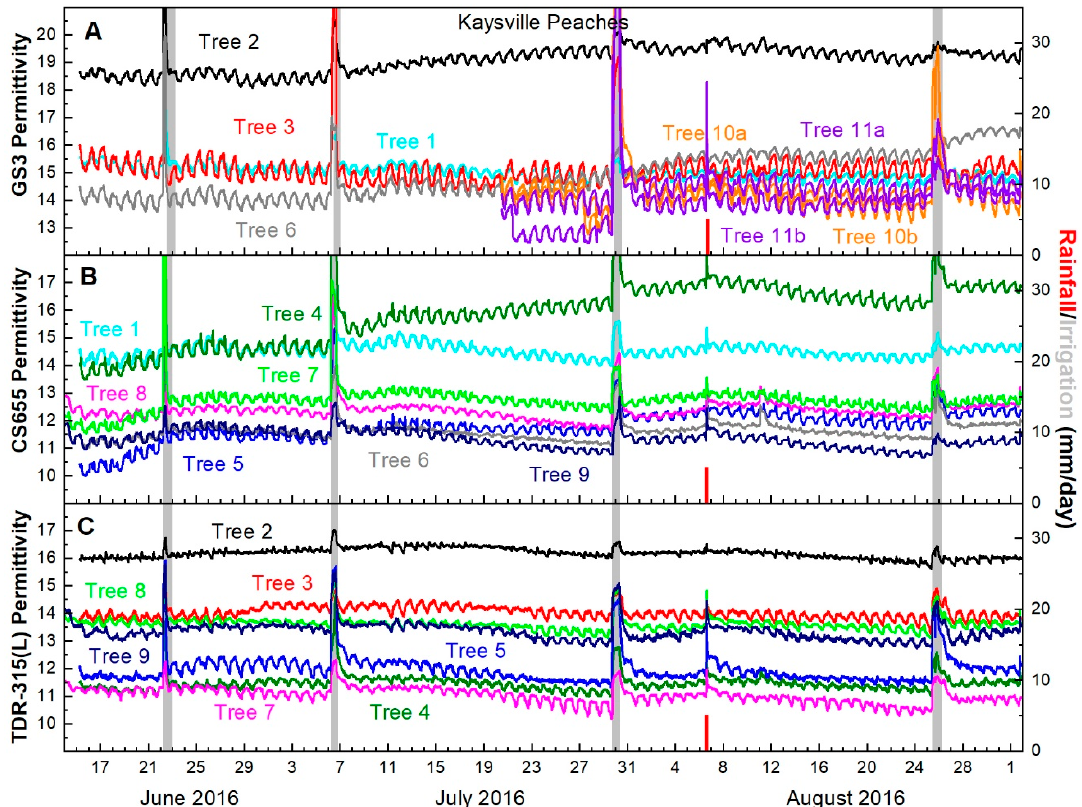
Figure 4. Peach trunk permittivity from ( A ) GS3 sensors ( B ) CS655 sensors and ( C ) TDR-315(L) sensors. Line colors indicate trees, not sensor models e.g., Tree 2 had one GS3 (black line in Figure 4A) and one TDR-315 (black line in Figure 4C). The single rainfall event on 5 August is indicated with a red bar, while irrigations are indicated with gray bars. Irrigation bars indicate date of irrigations and volumes varied by need. Table 2. Stem water potential and permittivity before and after differences for four irrigations. Stem water potential increases of 0.5 MPa corresponded to permittivity increases ranging from 0.27 to 0.39 units. p- Values are for a paired t -Test.